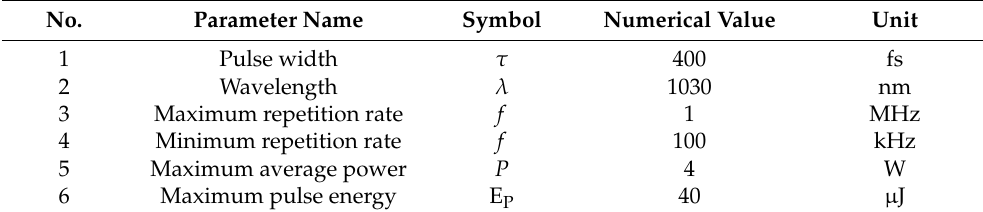
Table 1. Technical parameters of femtosecond laser.